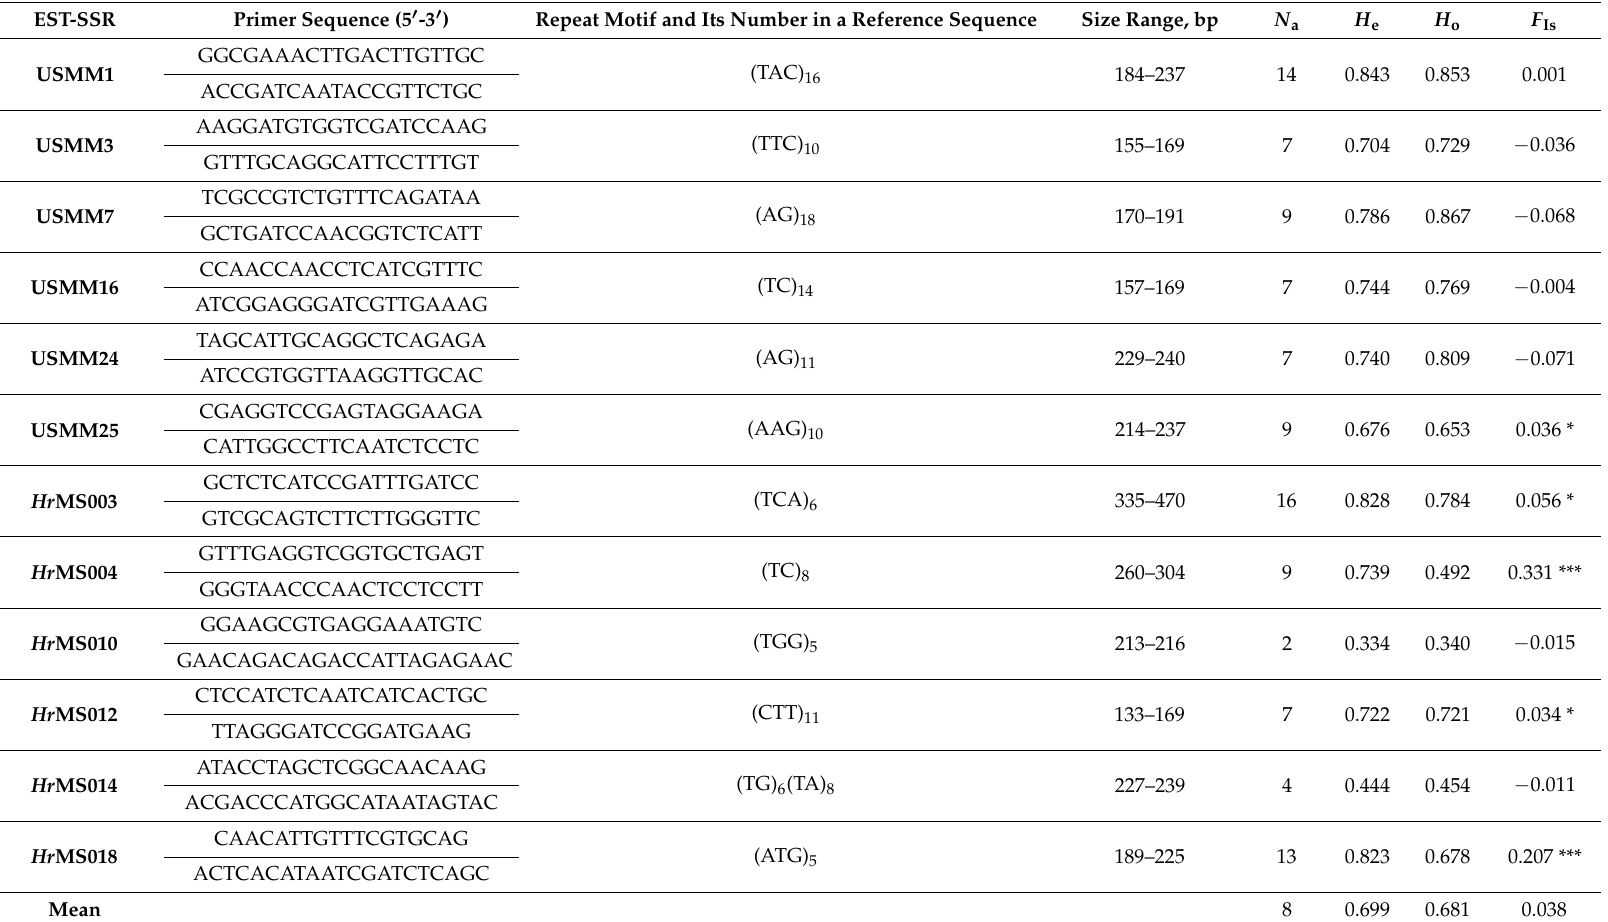
Table 4. Characteristics of 12 EST-SSR markers genotyped in sea buckthorn accessions of the Gilgit and Baltistan regions, northern Pakistan.